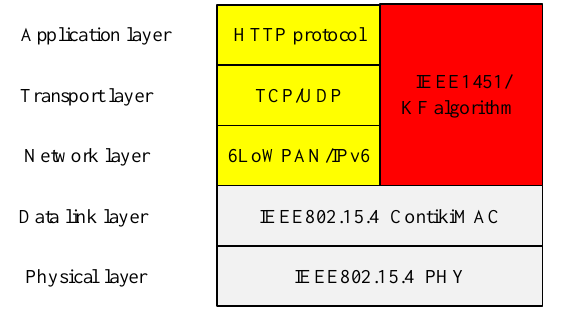
Figure 12. The integration of the KF into the Contiki system stack of the NCAP.